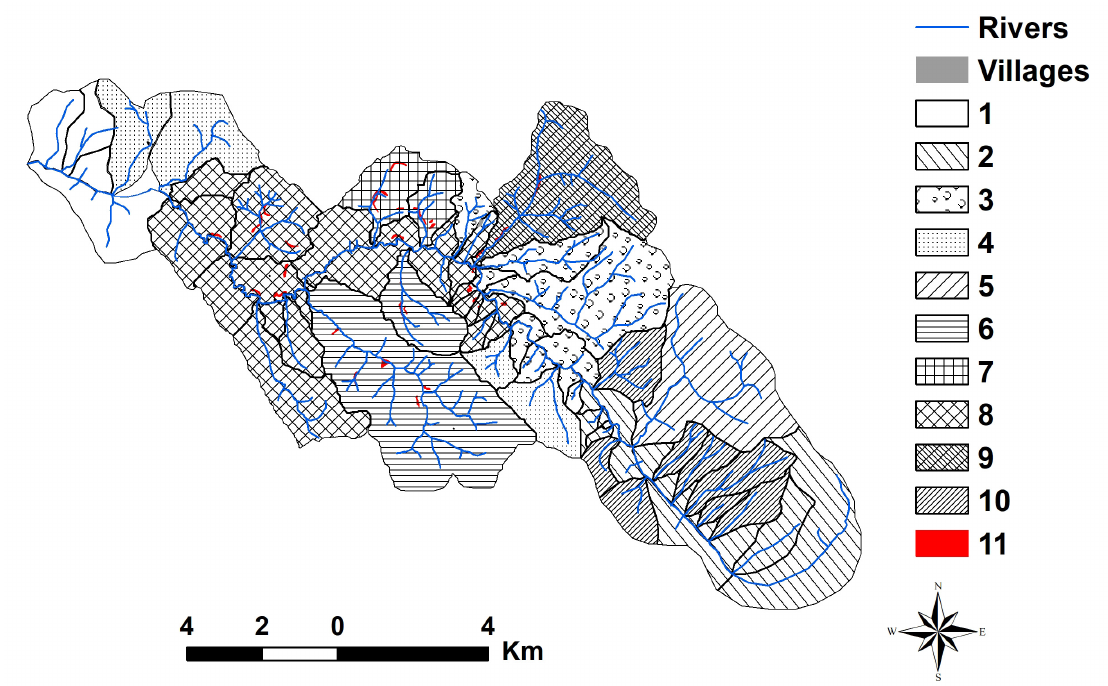
Figure 7. Planning decisions at the catchment level. 1-no special measures needed, 2-limitations for clear-cuttings aimed at preservation of forests share and spatial mosaics; 3-support for spontaneous a ff orestation, 4-preservation of forests in the upper catchments; 5-regulated cuttings aimed at increase of surface runo ff ; 6-reduction of plowing on steep slopes; 7-creation of forest bu ff er strips aimed at the protection from communal wastes; 8-expansion of forest bu ff er strips aimed at the protection from siltation and agricultural pollution; 9-a ff orestation on steep slopes instead of plowing; 10-selective cutting and prohibition of clear-cutting aimed at minimizing surface runo ff ; 11-proposed forested bu ff er